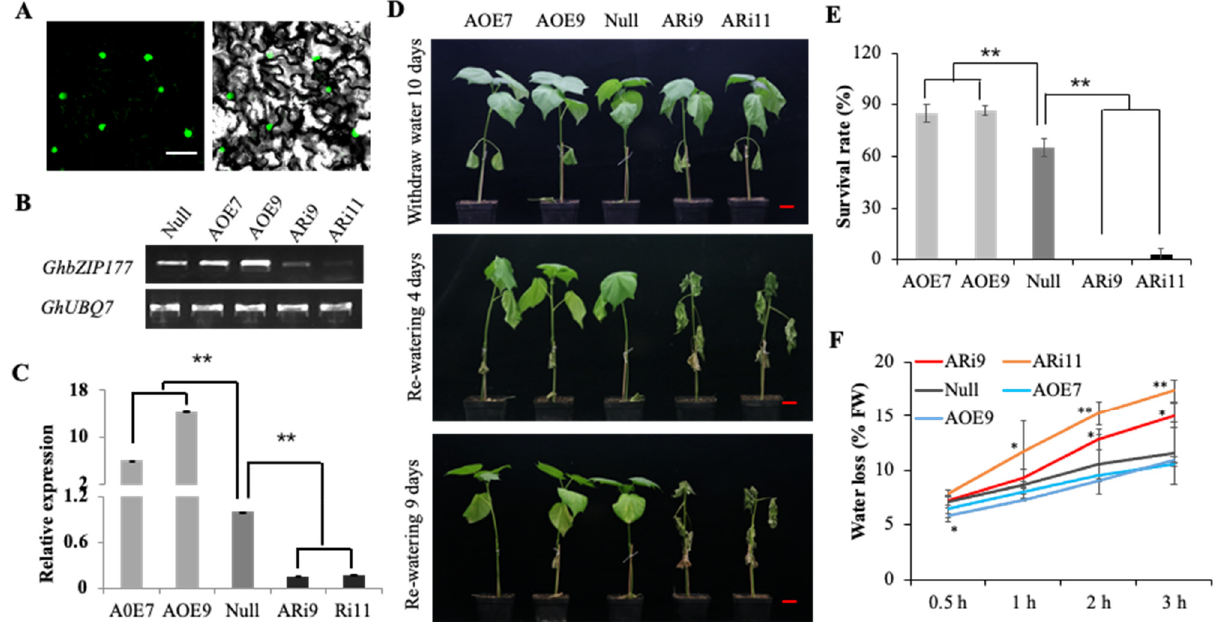
Figure 8. Functional analysis of GhbZIP177 under drought stress treatments. ( A ) Subcellular localization of GhbZIP177 in N. benthamiana leaf epidermis. Bars = 50 μ m. ( B , C ) Expression analysis of GhbZIP177 in transgenic lines in cotton. The values represent means ± SE ( n = 3). Significant difference analysis was calculated by LSD tests (** p ‐ value < 0.01). ( D ) Phenotypes of transgenic and WT cotton plants under drought stress treatments. Plants at trefoil stage in soil were exposed to drought stress for 14 days and then re ‐ watering. The photos were taken at 10 days withdrawing water, and 4 and 9 days after re ‐ watering. Bars = 3 cm. ( E ) Survival rate of transgenic and WT plants after 7 days after re ‐ watering. The values represent means ± SE ( n = 3). Significant difference analysis was conducted by LSD tests (** p ‐ value < 0.01). ( F ) Water loss of excised leaves from transgenic and WT plants at room temperature after 0.5, 1, 2, and 3 h. The values represent means ± SE ( n = 5). Significant difference analysis was conducted by LSD tests (* p ‐ value < 0.05, ** p ‐ value < 0.01).